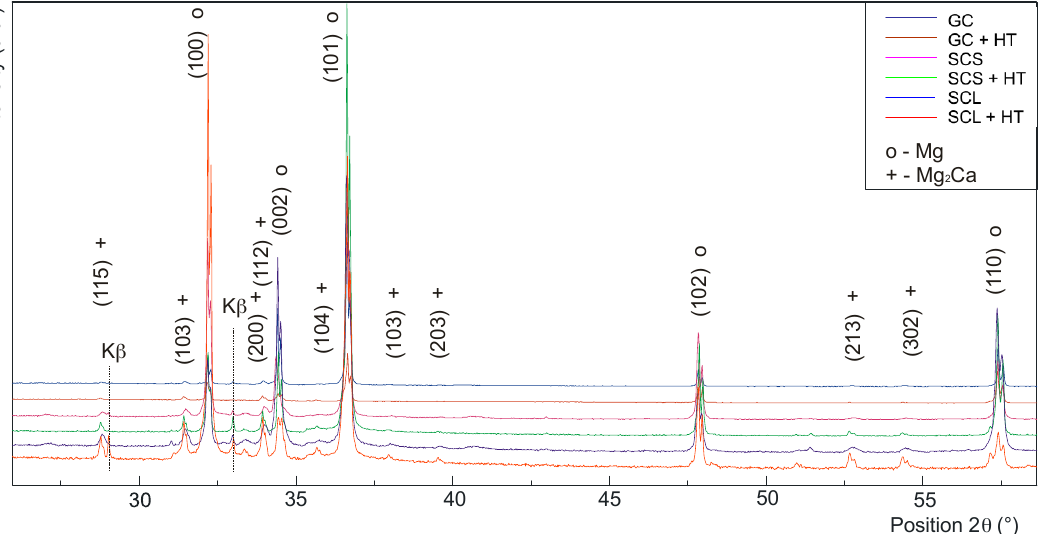
Figure 5. X-ray pattern of Mg-3Zn-2Ca magnesium alloy processed by different methods.